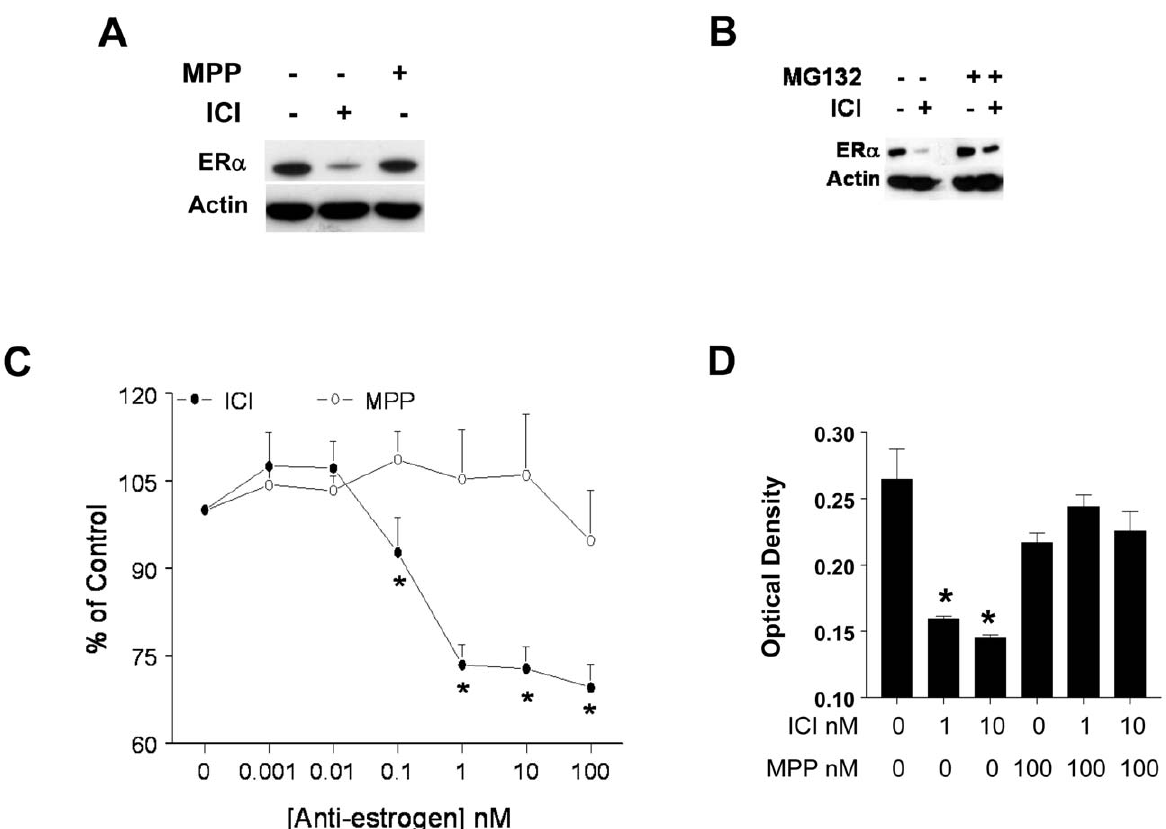
Figure 1. Differential effects of ER a antagonist on cell proliferation and ER a degradation. A] GH3 cells were treated with either vehicle, ICI (10 nM) or MPP (100 nM) for 5 days. Cell lysates were subjected to western blotting with an anti-ER a Ab ( top panel ). Equal loading was verified by using the anti-actin Ab ( lower panel ). Results shown are from a single experiment and it is a representative of 3 independent experiments yielding similar results. B] GH3 cells were treated either with 10 nM ICI for 1 hr, or pretreated with a broad-spectrum proteosome inhibitor MG132 (10 m M) for 1 hr, followed by ICI for 1 hr. Western blotting using anti-ER a Ab (Upper Panel) , or anti-actin Ab (Lower Panel) , was performed. Data is from a single experiment and is representative of 2 independent experiments yielding similar results. C] GH3 cells were treated with either vehicle or ICI (0.001, 0.01, 0.1, 1, 10 and 100 nM) or MPP (0.001, 0.01, 0.1, 1, 10 and 100 nM) for 5 days, and cell proliferation was determined as described in the materials and methods. Data is expressed as % of Control and it is the mean 6 SEM of 3 separate experiments. * indicates significant differences from control ( p , 0.05 ). D] GH3 cells were treated with either vehicle, ICI (1 and 10 nM) or pretreated with MPP (100 nM for 1 hr) followed by treatment with ICI (1 and 10 nM) for 5 days. Cell proliferation was determined, and data is expressed as optical density, and it is the mean 6 SEM of 4–6 determinations from a single experiment, which is a representative of 3 separate experiments with similar results. * designates significant differences from control ( p , 0.05 ).